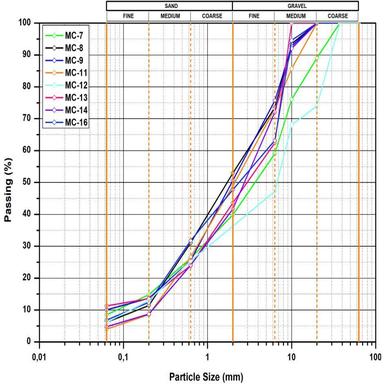
Particle Size Distribution (PSD) of the samples.